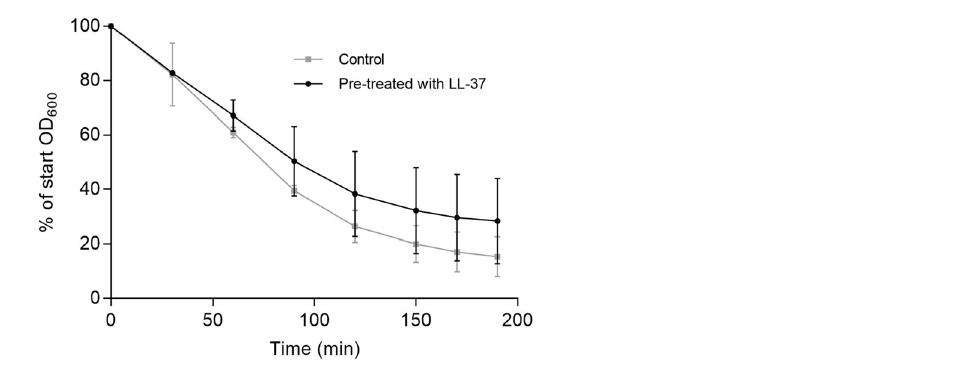
Figure 4. LL-37 exposure reduces Triton X-100 mediated autolysis. LL-37 induced autolysis measured as reduction of bacterial density over time in a 0.05% Triton X-100 solution containing treated (10 µg/ml LL-37) or untreated cultures. Error bars display 95% confidence intervals (n =